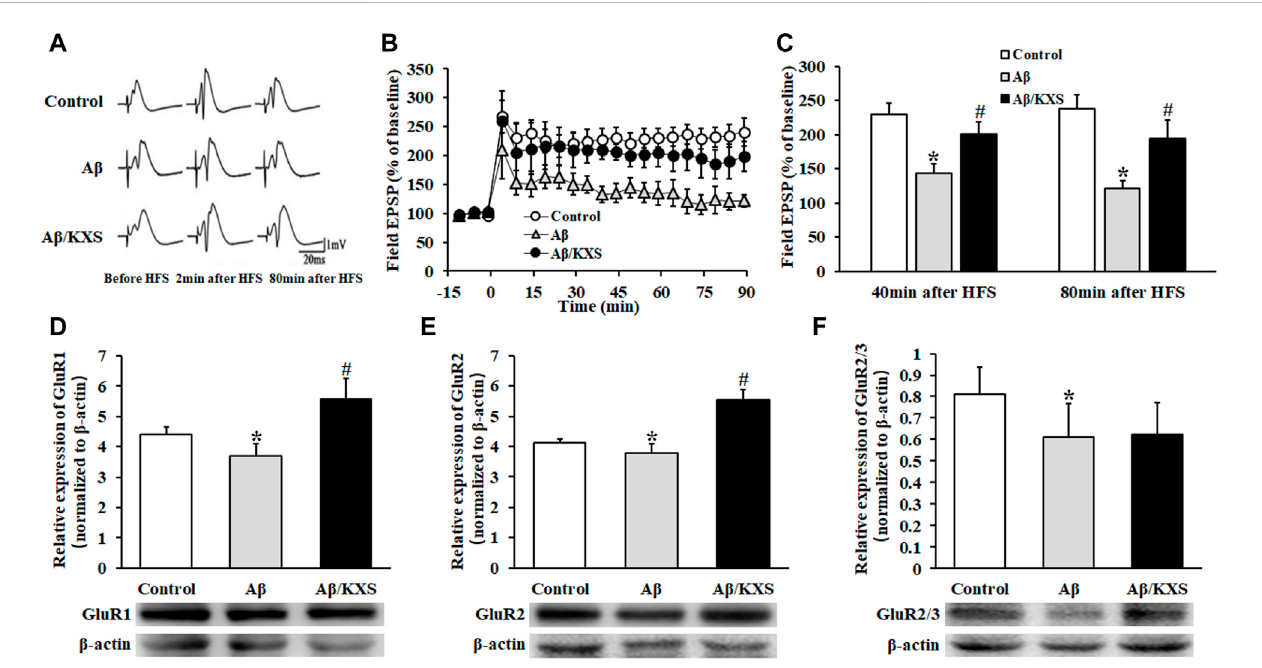
FIGURE 3 Effect of KXS on LTP and AMPAR expression. (A) fEPSP waveforms in each group at different stages. (B) Alterations in the fEPSP PS amplitude in each groupatdifferenttimepoints.At80 minpostHFS,thePSamplitudeintheA β /KXSgroupsigni fi cantlyincreasedcomparedwiththatintheA β group.Eachvalue represents the mean ± SE. (C) Statistical differences of mice in three groups at different time points. (D – F) Statistical analysis of the GluR1, GluR2, and GluR2/ 3expressionperformedfollowingWesternblotting.Thepicturesbelowthegraphindicatetheproteinexposure; n =6pergroup.Eachcolumnwithabar represents the mean ± SD. * p < 0.05 versus the control group; # p < 0.05 versus the A β